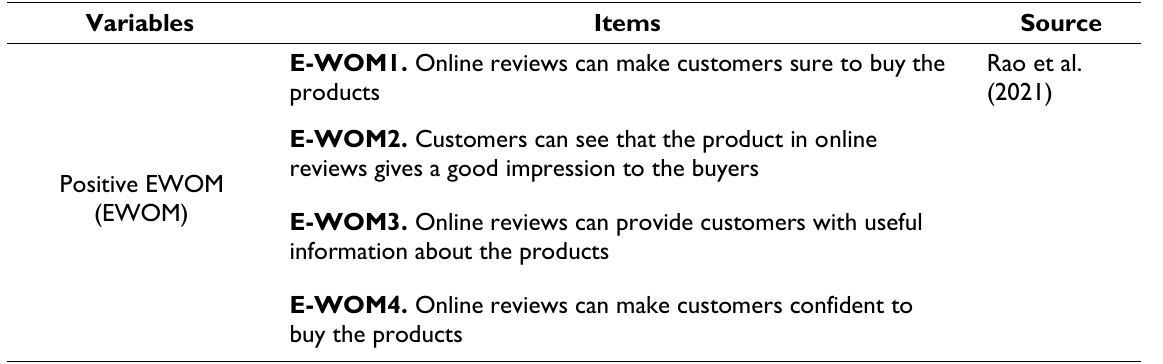
Table 1. Variables